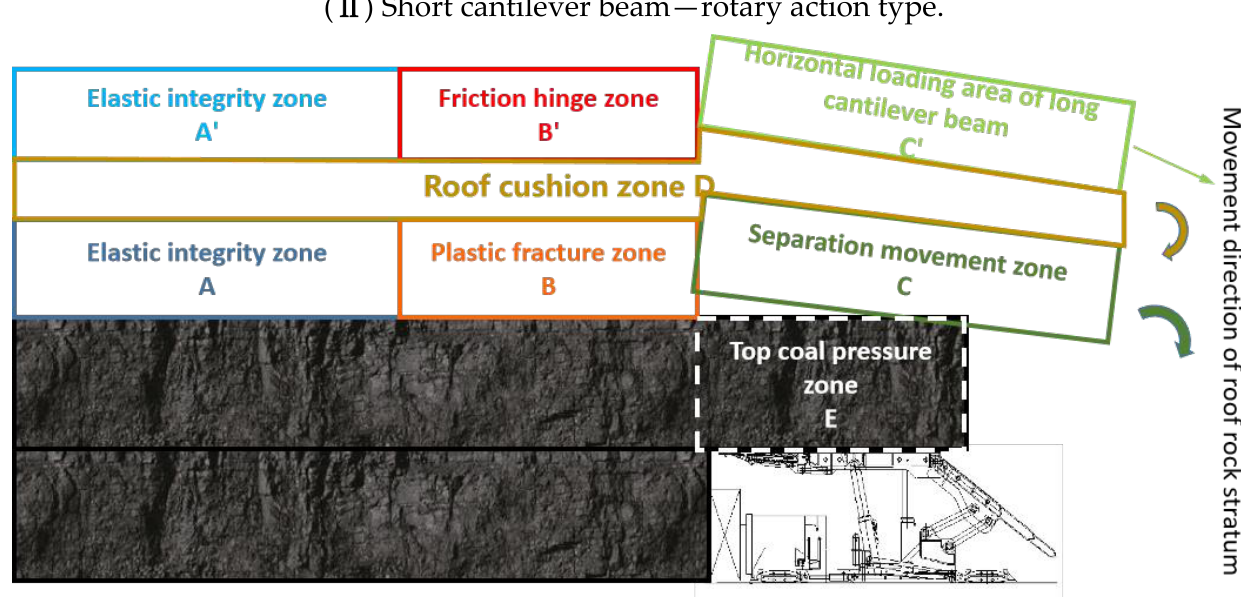
Figure 4. Typical state of overlying rock movement in a stope with a large mining height. Li H’s [12] discriminant theoretical formulas for mining overburden failure conditions have been clarified. Because the control effect of the direct roof strata is limited, it is not conducive to supporting working conditions and working face rock pressure control, that is, when the working face is pushed forward from the cutting position, it is assumed that the length of the free surface of the basic roof rock is the same as the pushing distance, and S is the balance judgment formula of the elastic deformation stage of the basic roof